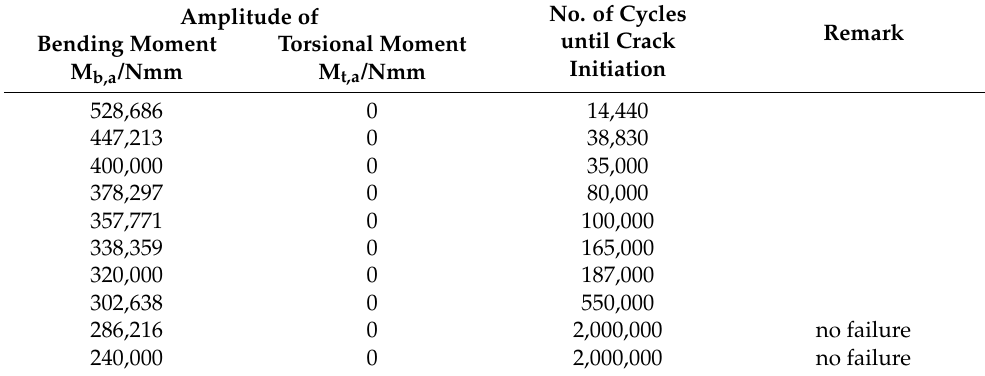
Table A1. Test results for pure bending tests.